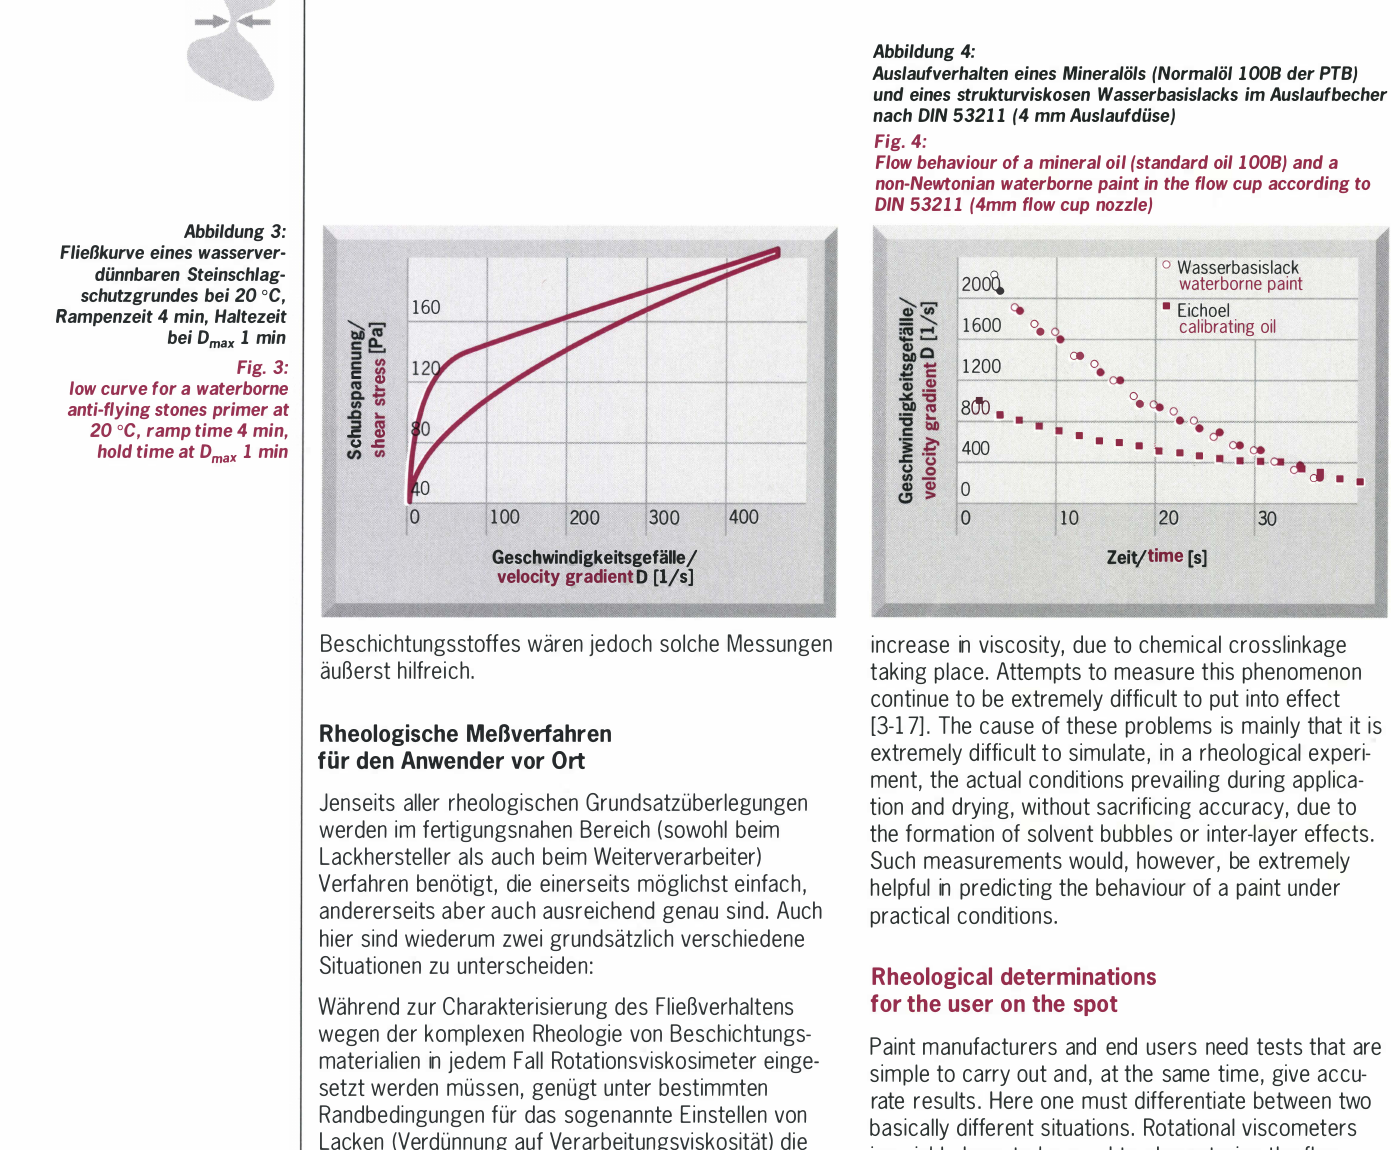
Fig. 4: Flow behaviour of a mineral oil (standard oil1008} and a non-Newtonian waterborne paint in the flow cup according to DIN 53211 (4mm flow cup nozzle}